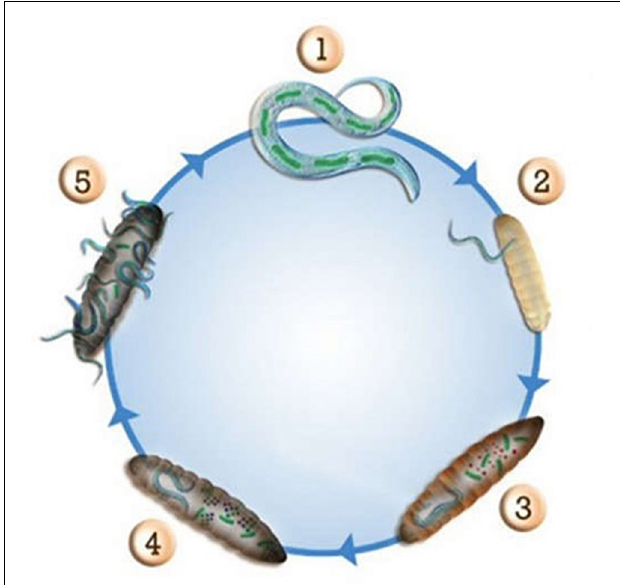
FIGURE 1 | Life cycle of entomopathogenic nematodes and their symbiotic bacteria in insect larvae. (1) Photorhabdus or Xenorhabdus bacteria live in the intestine of the host nematode; (2) The host nematode infects an insect; (3) Photorhabdus or Xenorhabdus bacteria are released within the insect and produce compounds to kill it; (4) Photorhabdus or Xenorhabdus bacteria produce a set of antibiotic molecules to prevent microbial competitors of the environment to degrade the corpse of the insect; (5) The nematode and the bacteria use the biomass of the insect as nutrients to reproduce. Photorhabdus or Xenorhabdus bacteria recolonize the nematode that will emerge from the corpse of the